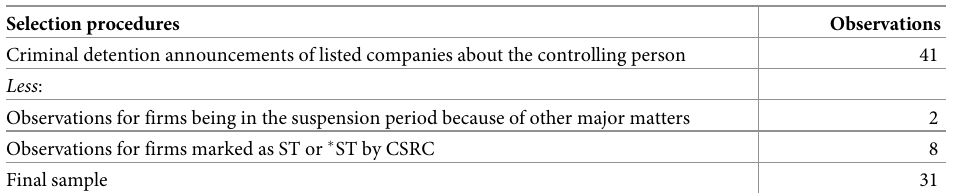
Table 2. Overview of the sample selection